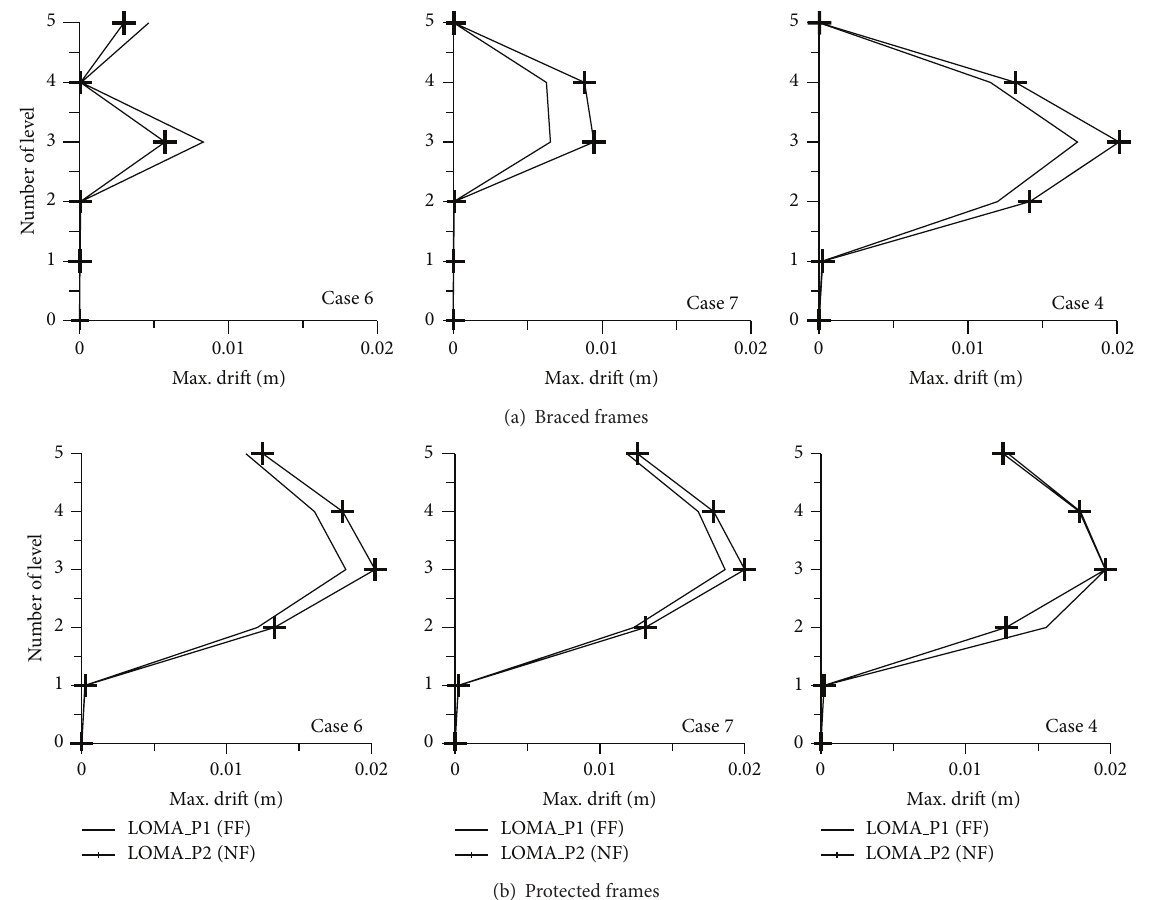
Figure 7: Maximum interstory drift for cases 6, 7, and